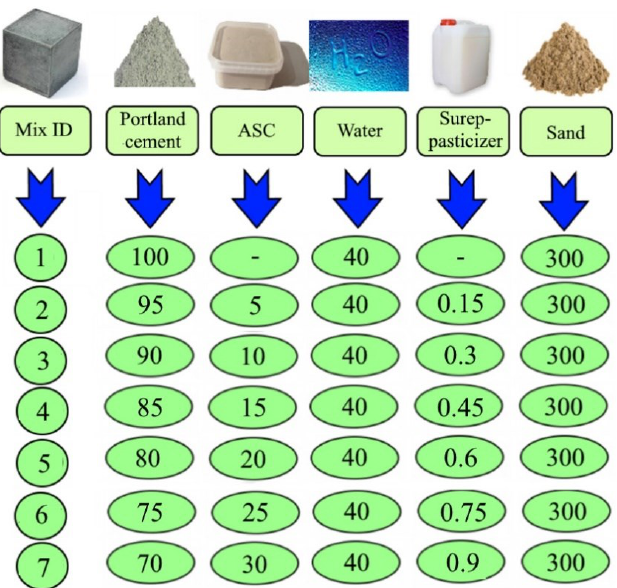
Figure 8. Mix proportions (in fractions).